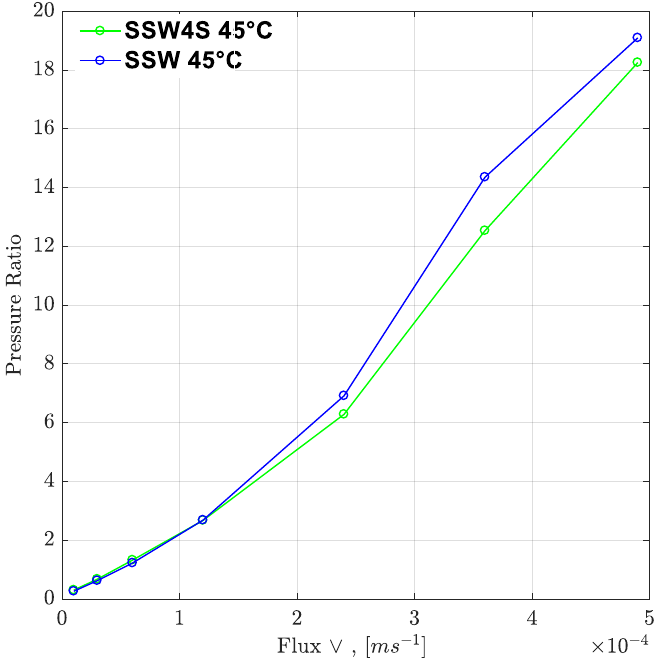
Figure 22. Pressure ratio as function of flux rate (two polymers). SSW4S represents the polymer solutions in synthetic seawater with quadruple sulfates and SSW denotes polymer solutions in synthetic seawater. Pressure ratio is defined as the polymer pressure drop at each flux rate divided by pressure drop for brine flood at flux rate of 10 feet/day.